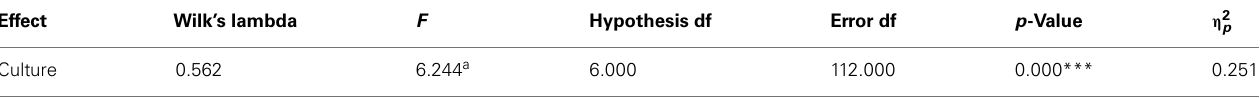
TableA7 | Between-subjects MANOVA to investigate the effects of culture on intensity difference scores from ipsatized data.